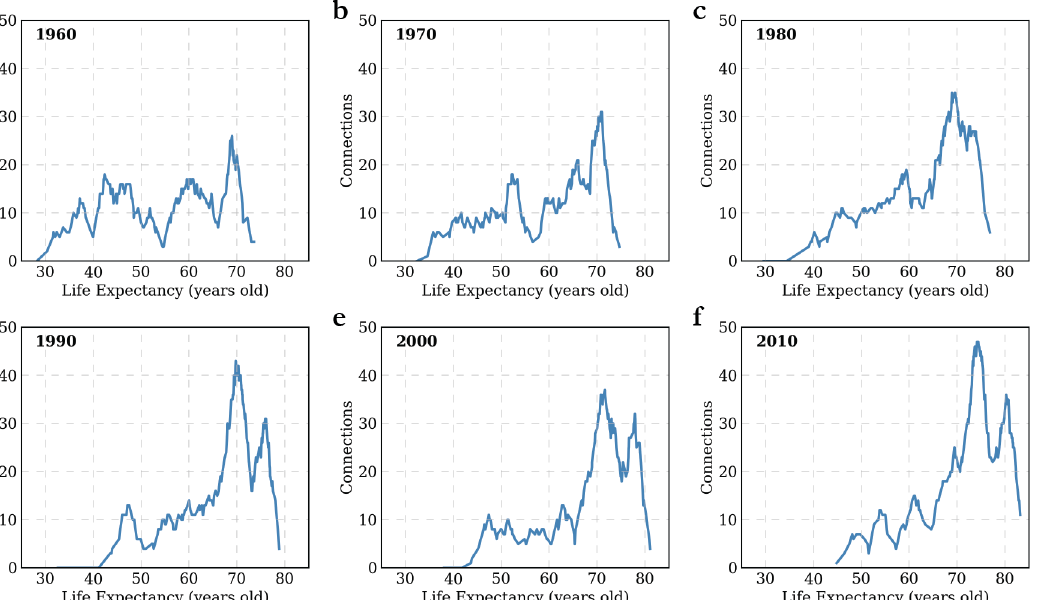
Fig 4. NB Histograms of Evolution of Life Expectancy in the World from 1960 to 2010. (A)-(F) 1960, 1970, 1980, 1990, 2000, 2010. (Data Source: World Bank)